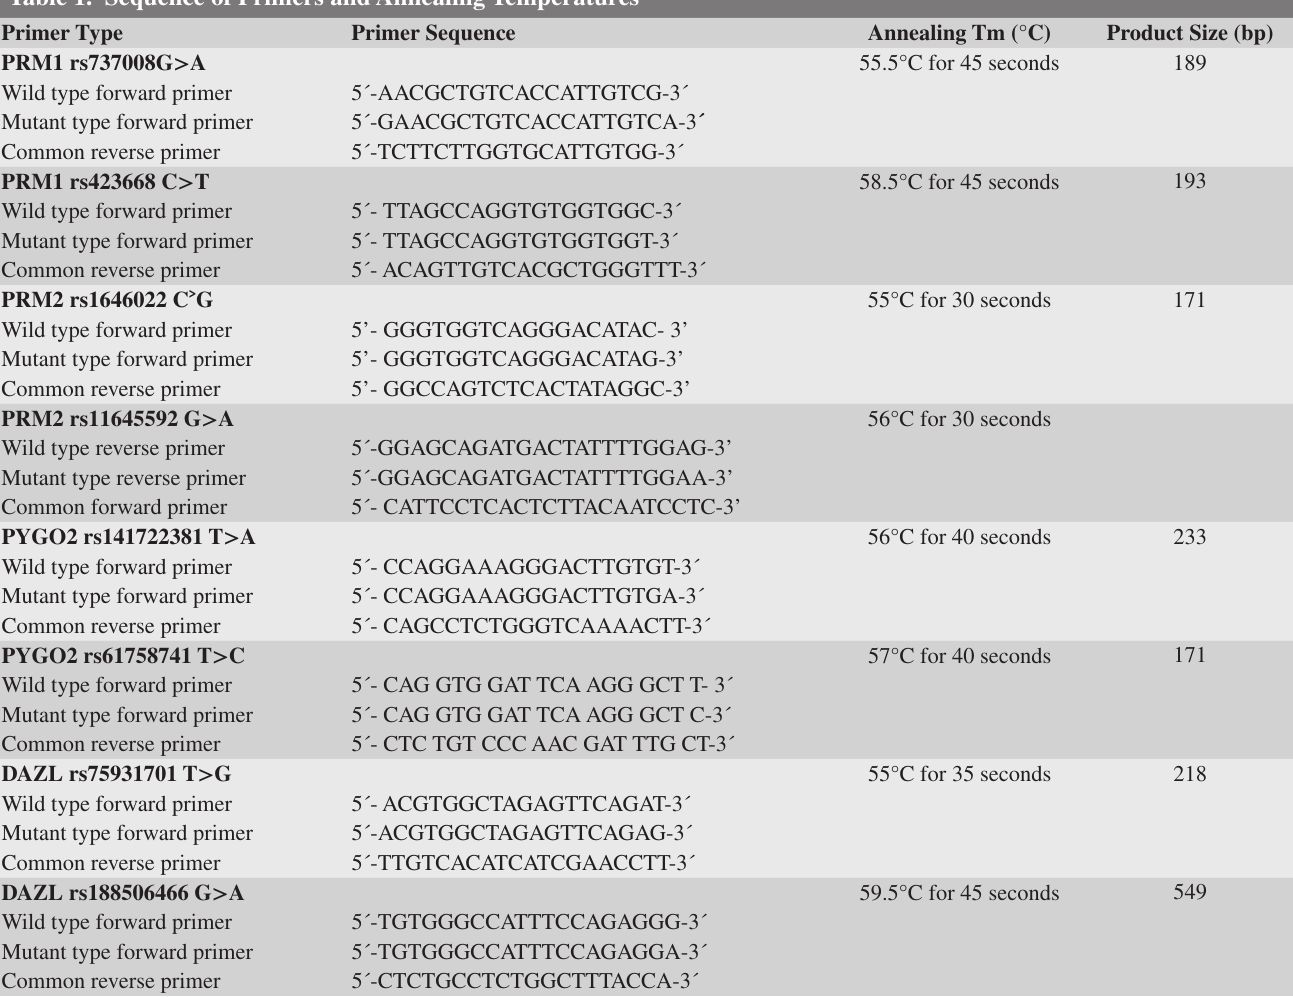
Table 1. Sequence of Primers and Annealing